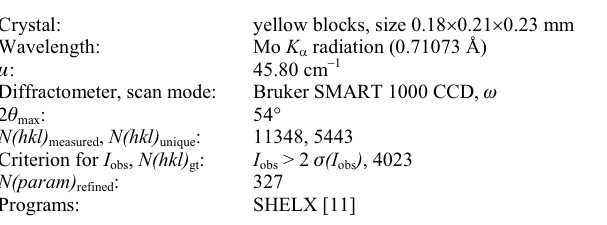
Table 1. Data collection and handling.